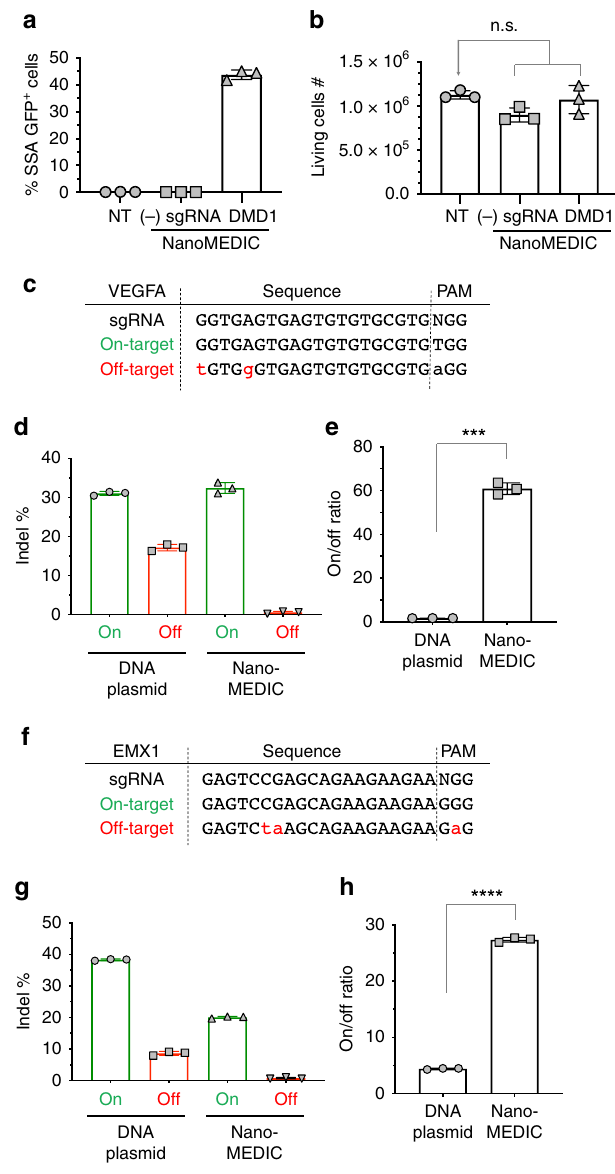
Fig. 5 NanoMEDIC-mediated gene editing is not toxic and reduces off- target activity compared with plasmid DNA transfection. a , b All-in-one NanoMEDIC particles containing RGR-DMD1 or no sgRNA were inoculated onto HEK293T EGxxFP reporter cells. SSA-GFP + expression was analyzed by fl ow cytometry a and cell number was counted 2 days after inoculation b . n.s. not signi fi cant by one-way ANOVA. % SSA – GFP + cells and living cell #: mean±S.D. from technical triplicates. c – h HEK293T cells were either transfected with CRISPR DNA plasmids or inoculated with NanoMEDIC targeting VEGFA or EMX1. Three days after treatment of the cells, genomic DNA was extracted and indel % was determined by TIDE analysis. Mean± S.D. from technical triplicates. c Sequences for VEGFA sgRNA, and on-target and off-target sites are shown. d Indel % at the VEGFA on-target and off- target sites are shown for DNA plasmid and NanoMEDIC delivery. Mean± S.D. from technical triplicates. e The on/off ratio using each delivery method at the VEGFA site is depicted. **, P = 0.005 by unpaired two-tailed t test. Mean±S.D. from technical triplicates. f Sequences for EMX1 sgRNA, and on-target and off-target sites are shown. g Indel % at the EMX1 on-target and off-target sites are shown for DNA plasmid and NanoMEDIC delivery. Mean±S.D. from technical triplicates. h The on/off ratio using each delivery method at the EMX1 site is depicted. ****, P <0.0001 by unpaired two-tailed t test. Mean±S.D. from technical triplicates. Source data are provided as a Source Data fi